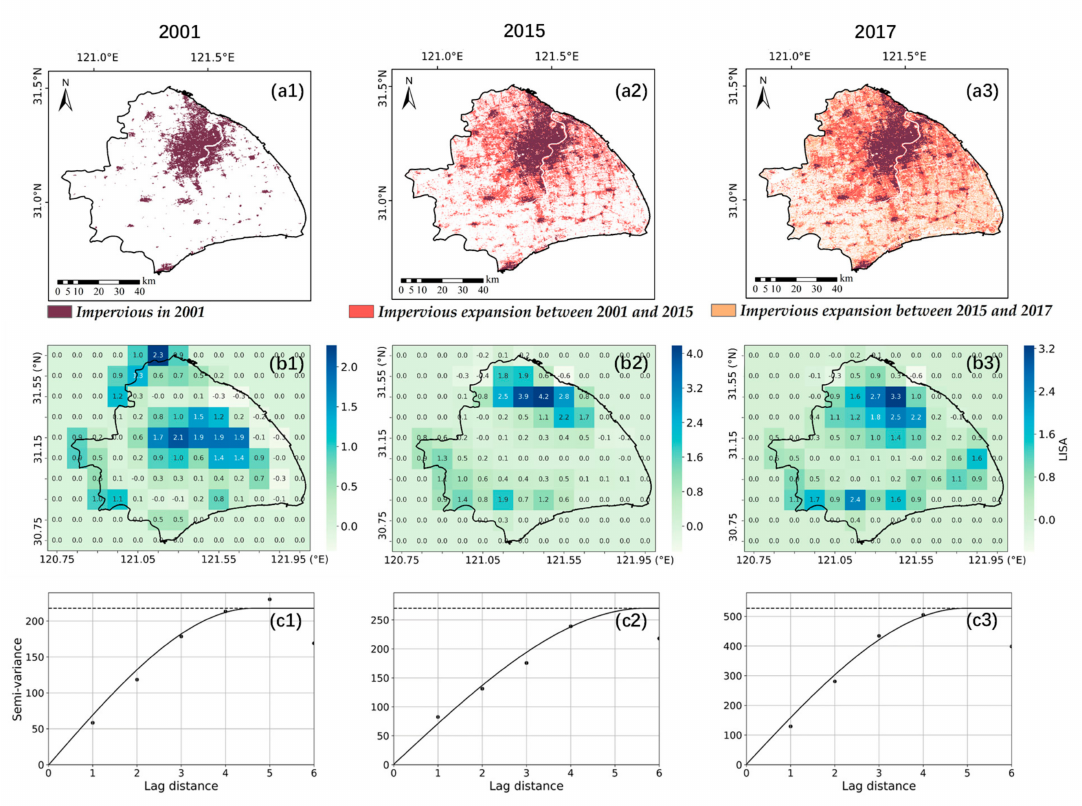
Figure 15. Influence of urban growth on spatial heterogeneity of 3-h extreme rainfall in SH: ( a ) Land use maps (only focus on impervious) in 2001, 2015, 2017, ( b ) LISA maps in 2001, 2015, 2017, ( c ) Semi-variance analysis in 2001, 2015,